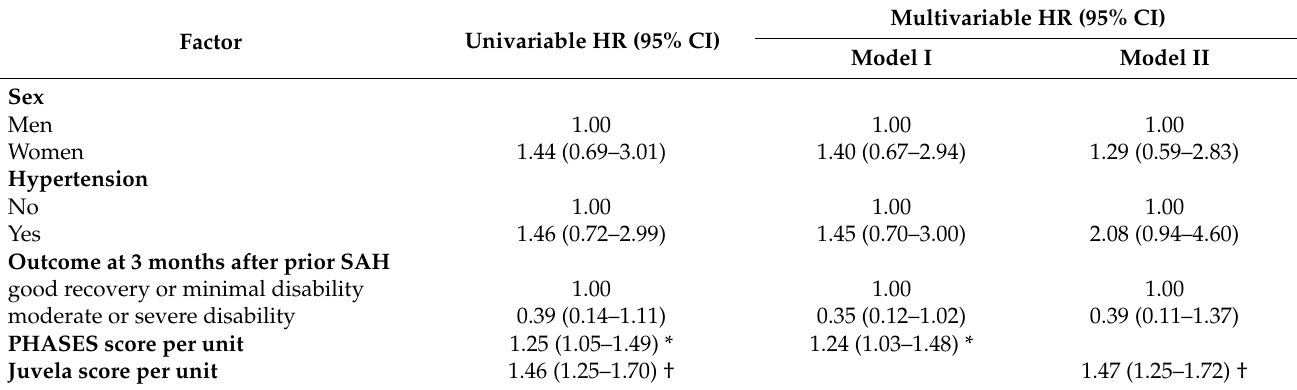
Table 2. Risk factors for the rupture of unruptured intracranial